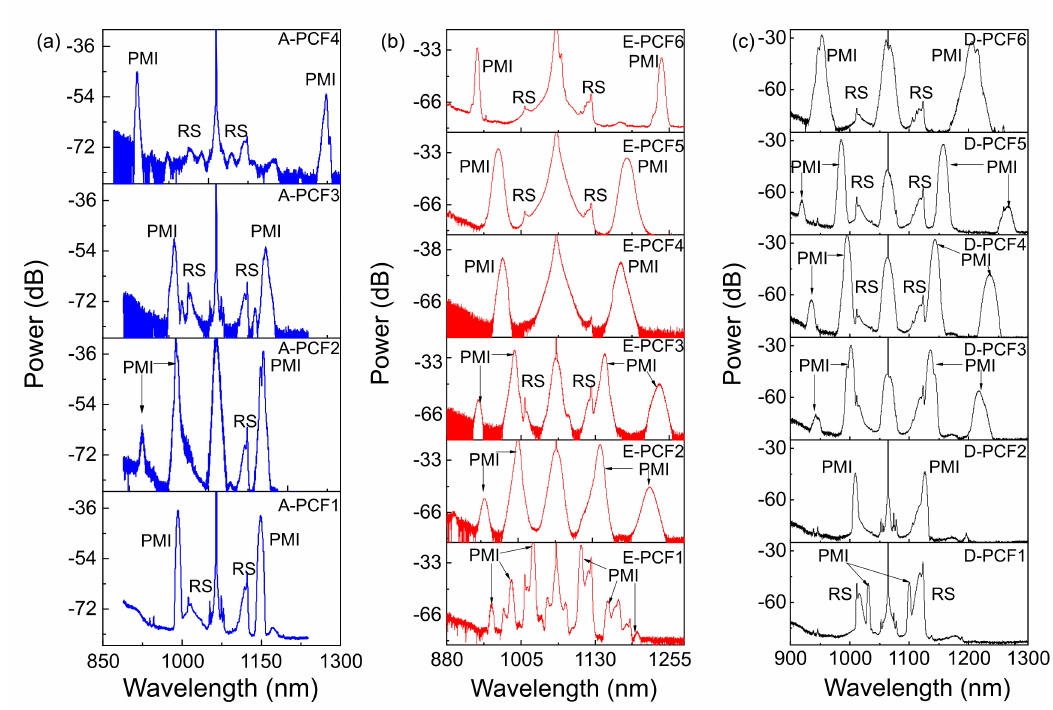
Figure 10. PMI spectra generated in ( a ) air-filled PCFs (blue line), ( b ) ethanol-filled PCFs (red line) and ( c ) D 2 O-filled PCFs (black line). Table 4. Wavelength and frequency shift of PMI–SF bands generated in air-filled, ethanol-filled